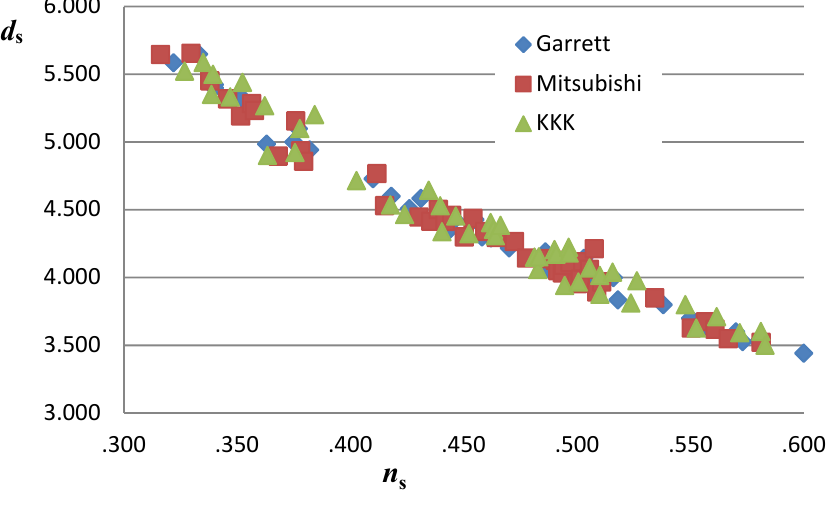
Figure 7. Comparison of the trends of the η max of three different